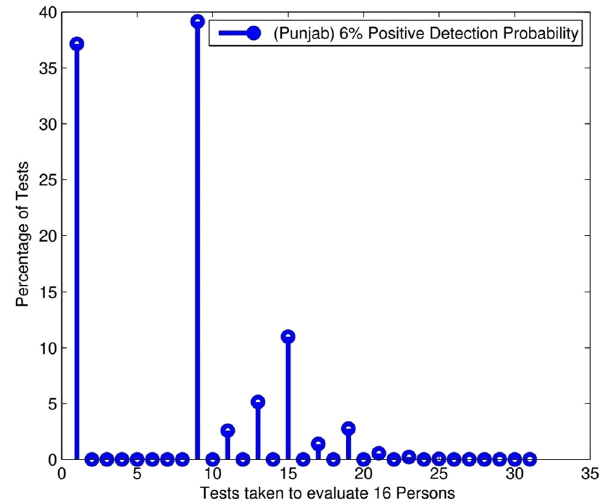
Figure 11: Population - based study with seven sample pools of 16 individuals